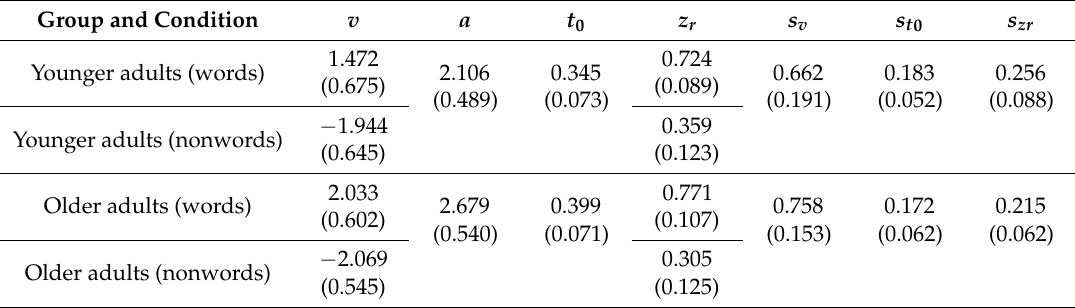
Table 3. Summary of diffusion model